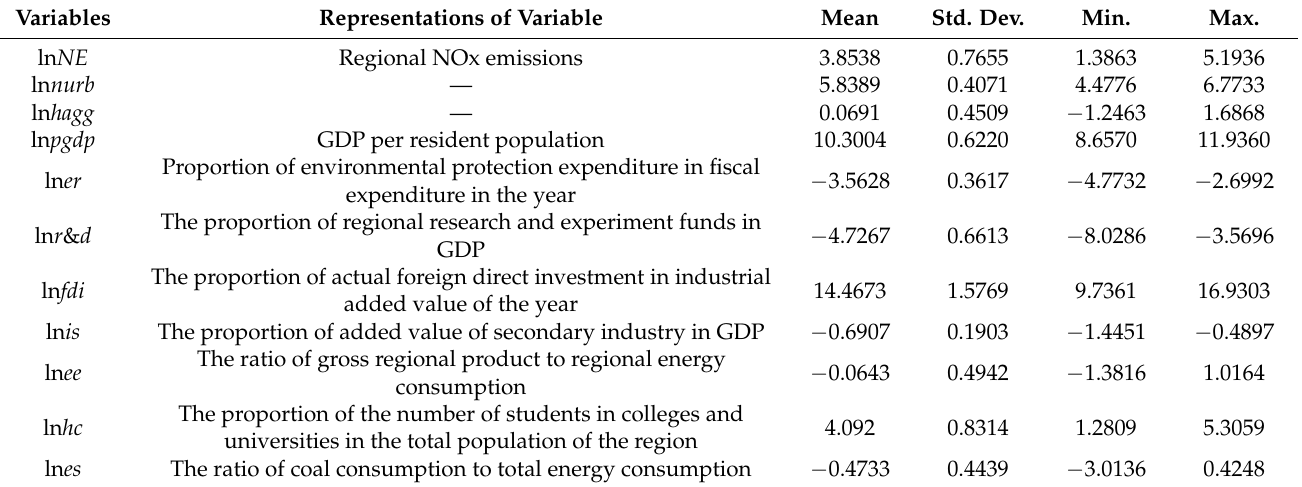
Table 2. Variable description statistics.